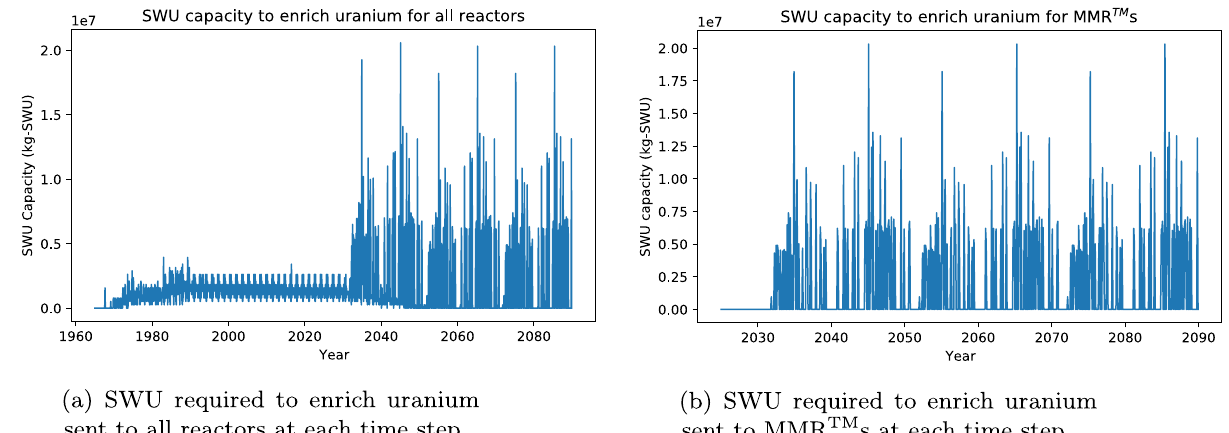
Fig. 6. Enriched uranium mass sent to reactors in Scenario 2.